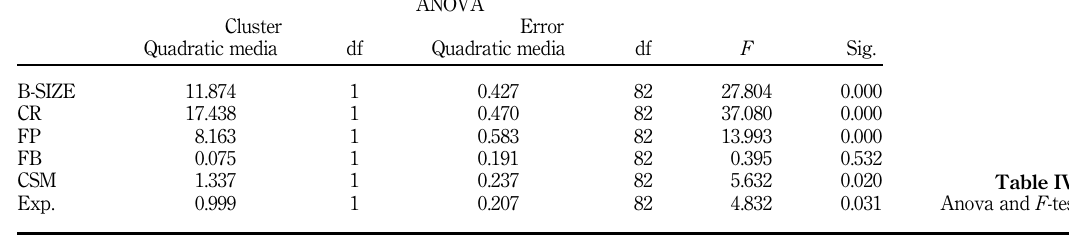
Table IV. Anova and F -test